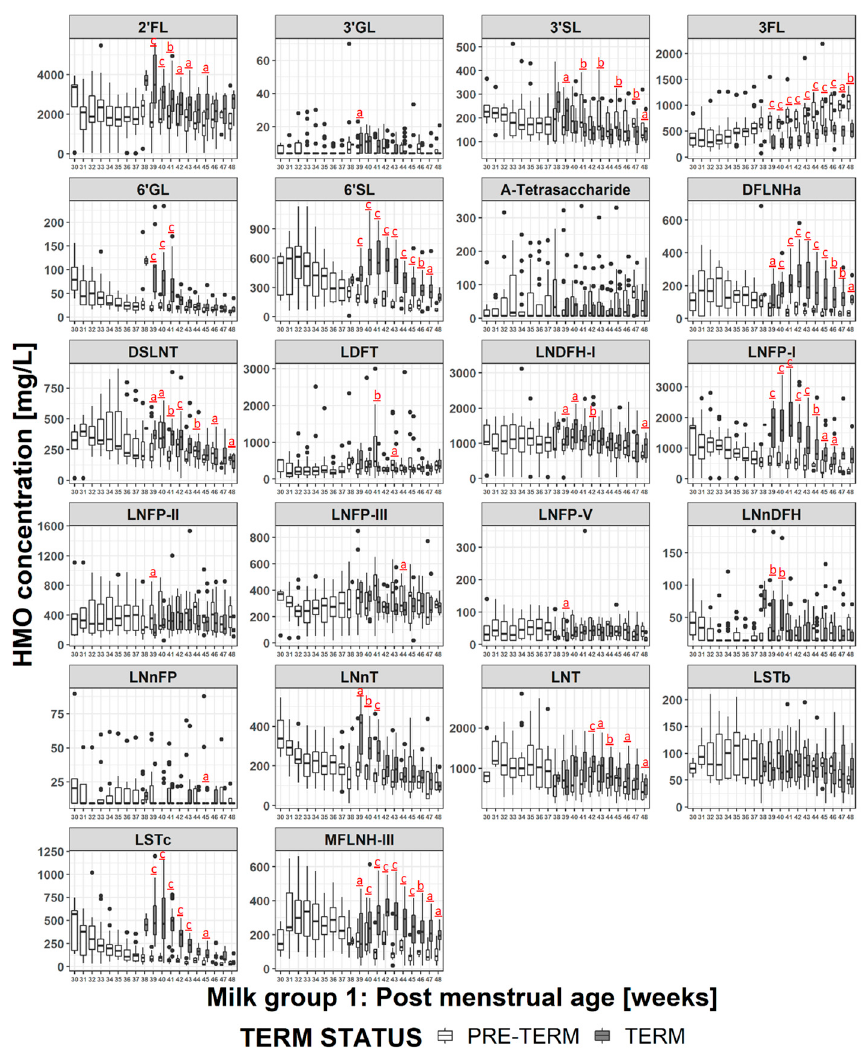
Figure 7. Comparison of the HMO concentration in group 1 milk of mothers giving birth to term (grey bars) or preterm (white bars) infants at equivalent gestational age. a: p < 0.05, b: p < 0.005 c: p < 0.0005.